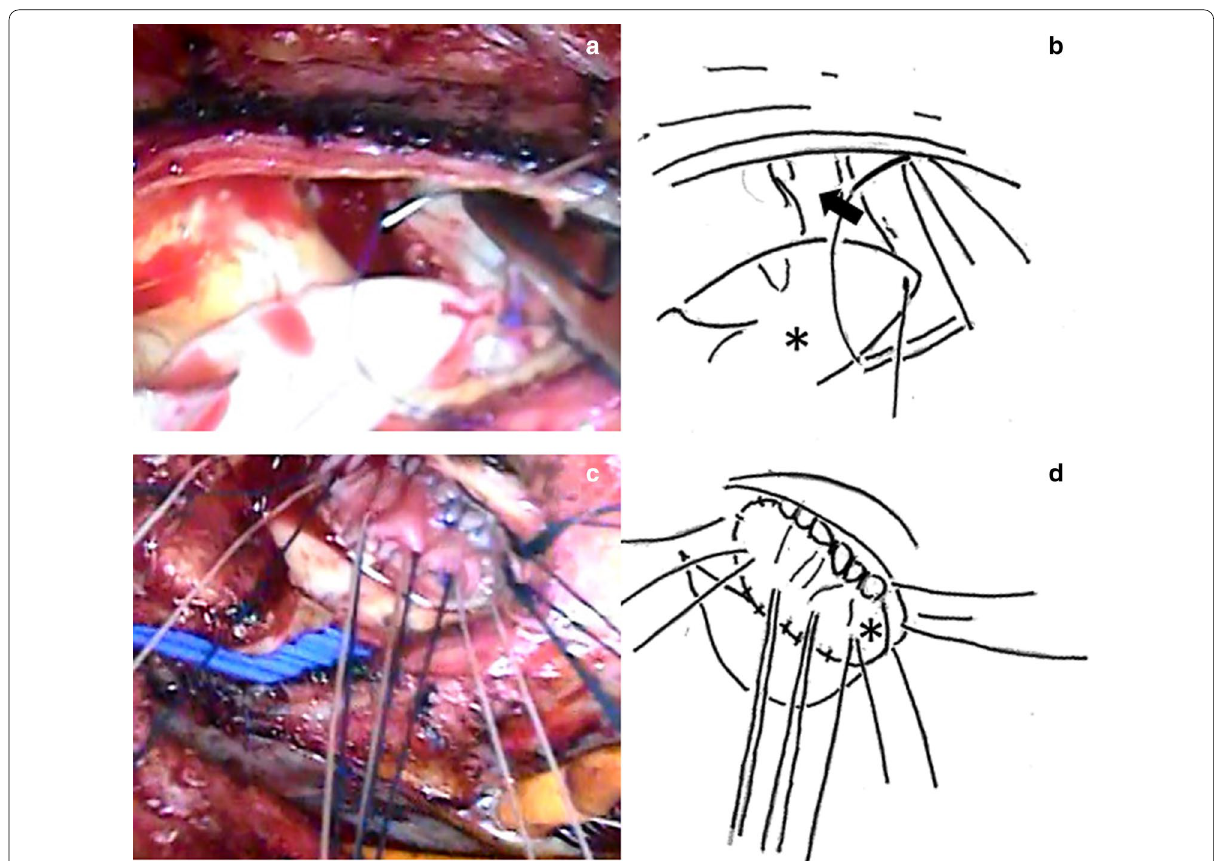
Fig. 3 a , b After copious irrigation of the abscess cavity (arrow), an aortic annulus reconstruction was carried out with a bovine pericardium patch (asterisk) using continuous 4-0 monofilament sutures. c , d Suturing from outside of the aortic root to the bovine aortic annulus (asterisk) with non-everting